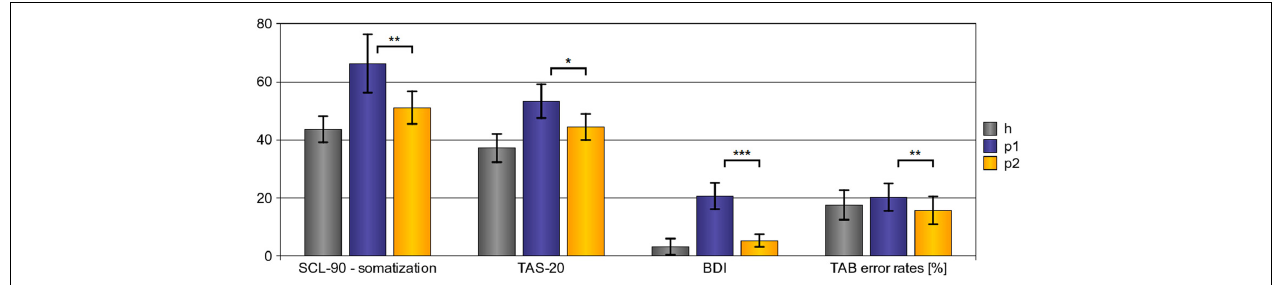
FIGURE 1 | Behavioral results—effects of psychotherapy. After psychotherapy we observed a significant reduction of somatization severity (SCL-90 - somatization scores), to enhanced emotional awareness (TAS-20 scores), and to a reduction of depressive symptoms (BDI scores). In addition, emotion recognition abilities improved after psychotherapy as shown by a